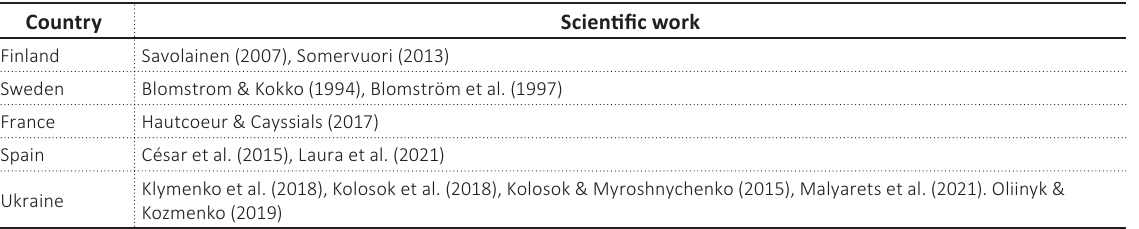
Table 2. Academic papers on the net investment position of developed European countries and